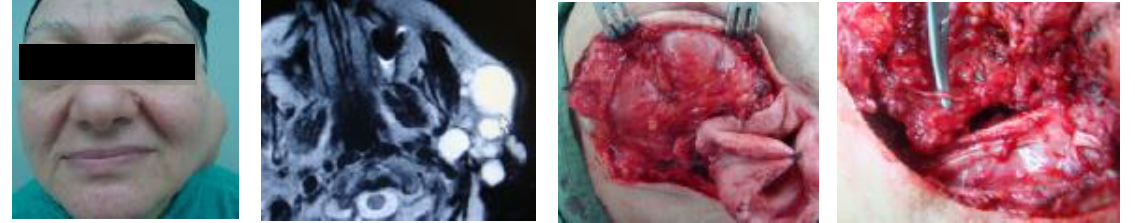
Figure 6: Patient with a recurrence of multi-nodular pleomorphic adenoma of left parotid